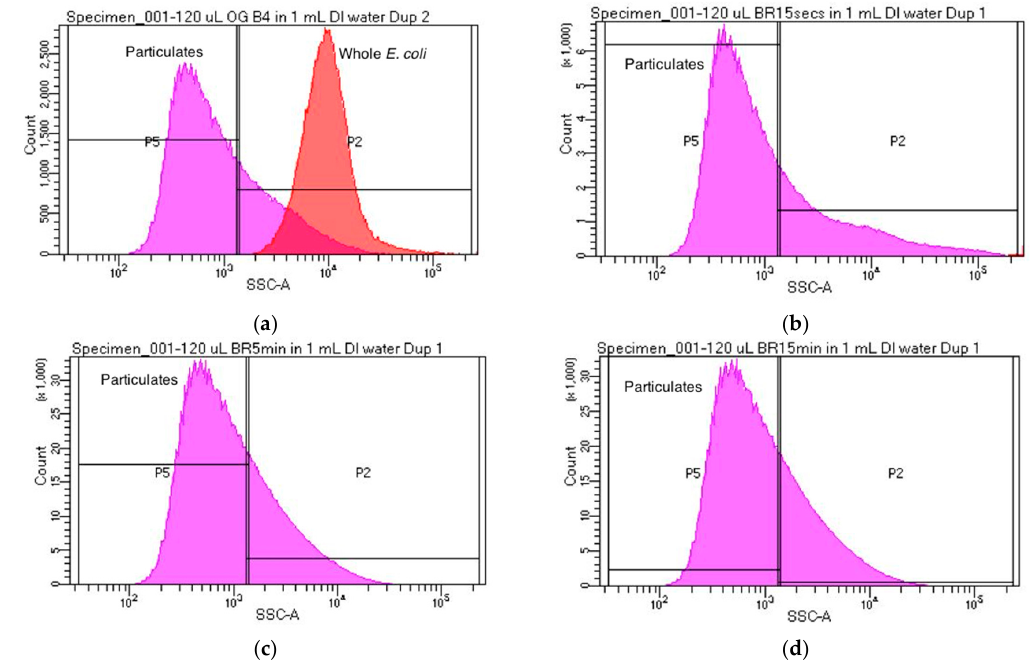
Figure 4. Population side scatter distribution for each sample tested. In each plot, the curve labeled “Whole E. coli ” corresponds to the side scatter distribution of whole E. coli cells, while the curve labeled “Particulates” corresponds to debris and other particulates that are not whole E. coli cells. ( a ) Side scatter distribution for the original sample which did not undergo treatment with the ER; ( b ) Side scatter distribution for a sample which underwent 15 s treatment with the ER; ( c ) Side scatter distribution for a sample which underwent 5 min treatment with the ER; ( d ) Side scatter distribution for a sample which underwent a 15 min treatment with the ER.